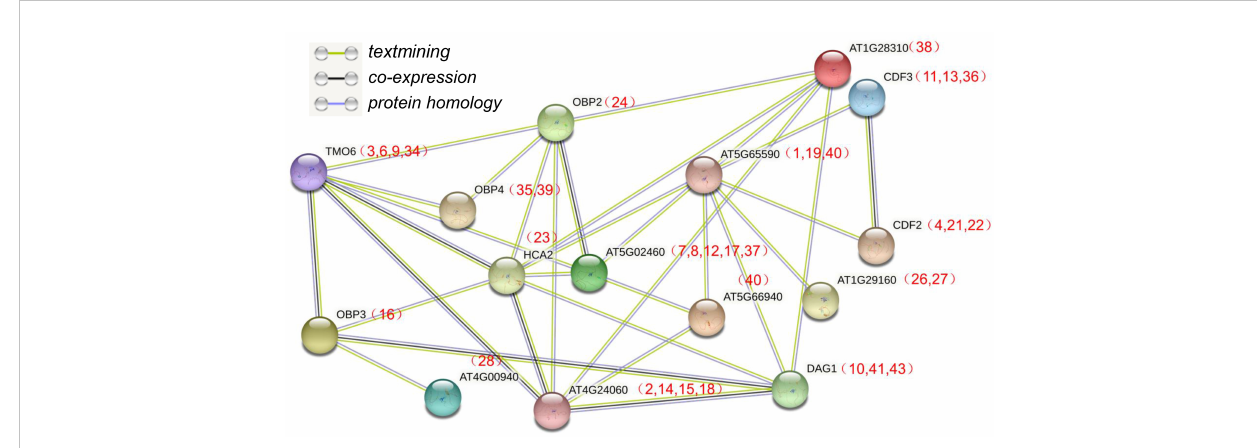
FIGURE 8 Interaction networks of IbDof proteins in sweetpotato according to the orthologues in Arabidopsis. The amino acid sequences of IbDofs were employed to search the STRING database, network node represents proteins, and edge represents protein – protein associations. The colored lines between the nodes indicate the different kinds of interactions. The numbers ( IbDof gene number) in brackets represent the corresponding orthologues in